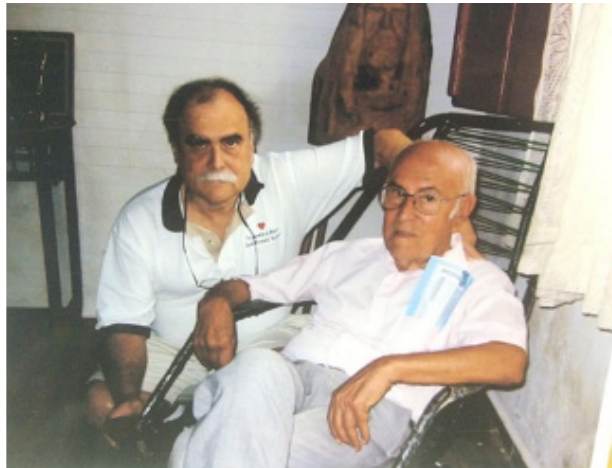
Fig. 3 - Tomas with his father José in the city of Cássia, Brazil.